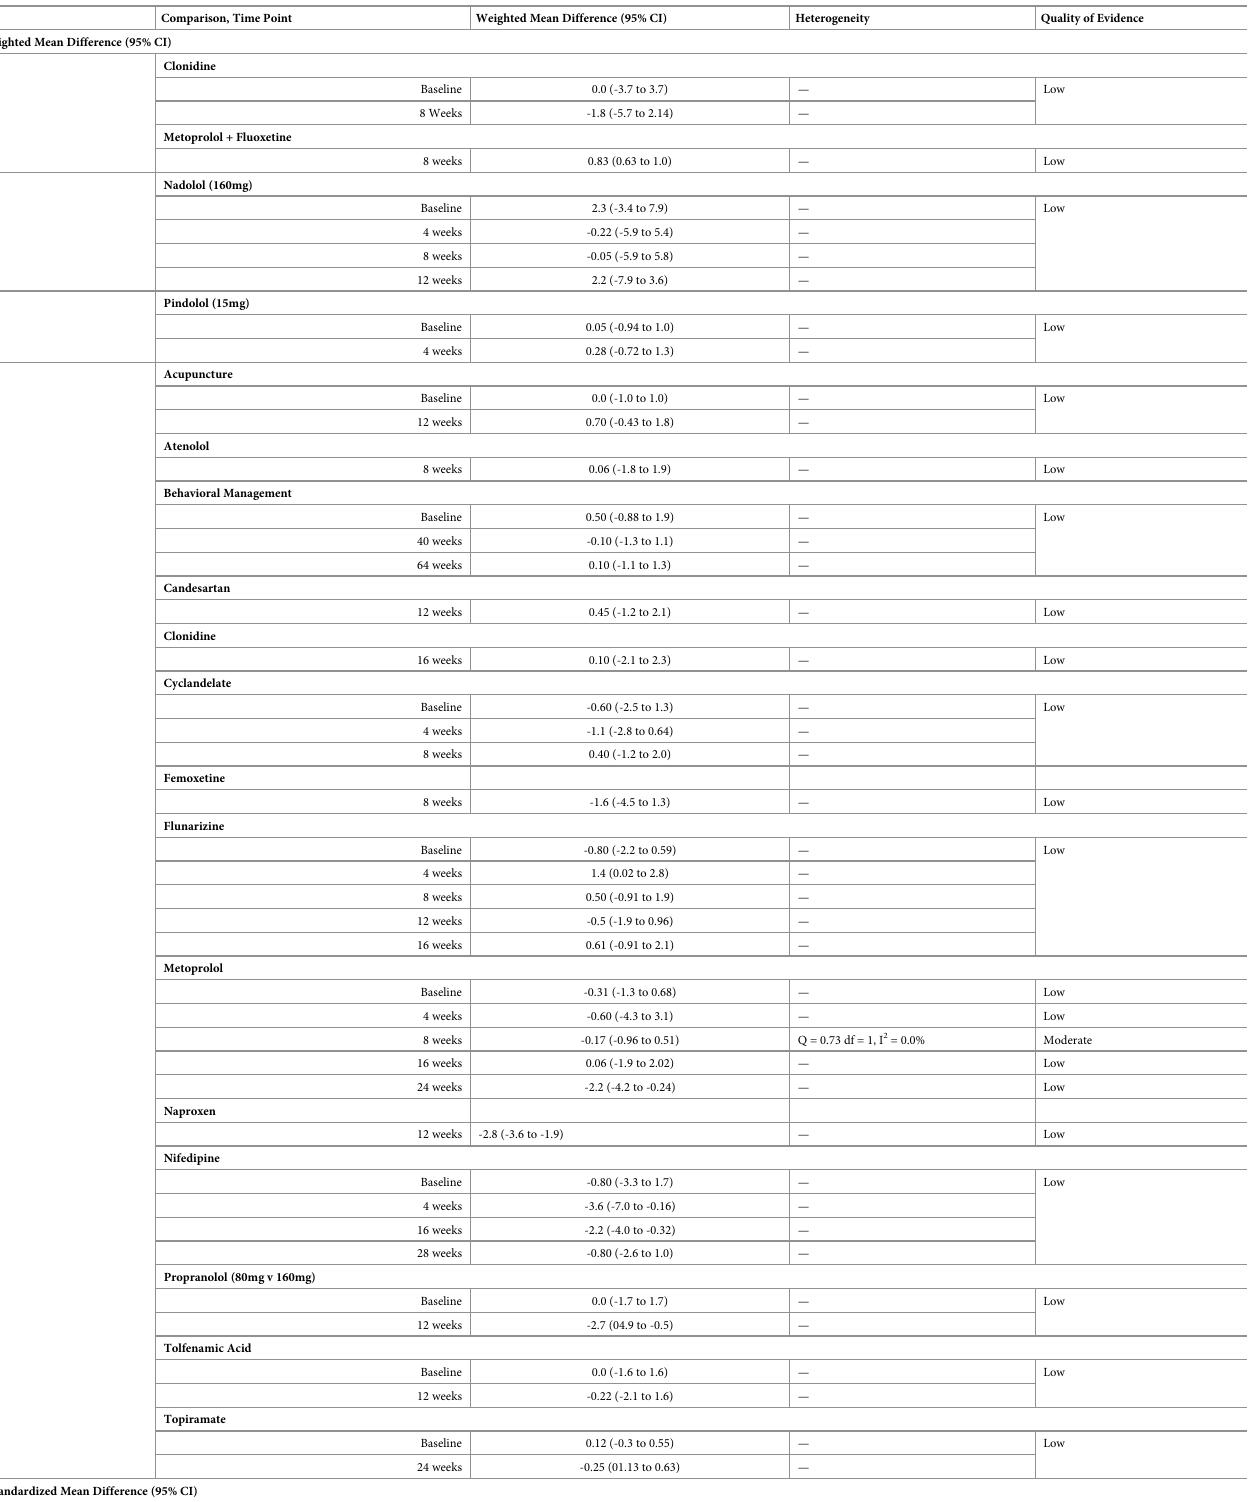
Table 5. Secondary outcomes of comparative effectiveness